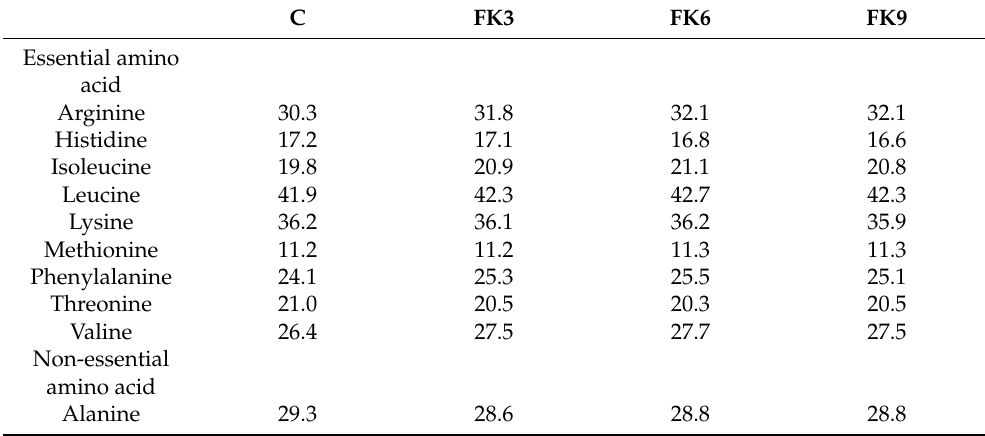
Table 2. Amino acid composition of experimental diets (g/kg diet, in as is